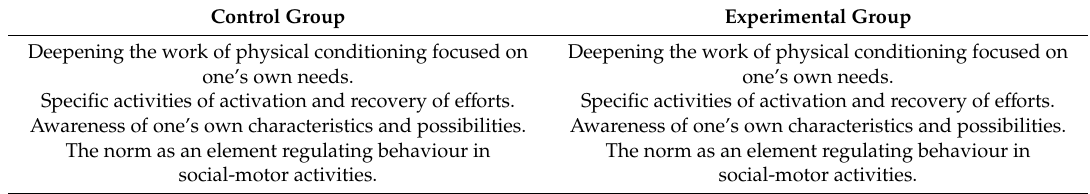
Table 2. Contents worked on during the sessions in the control group and in the experimental